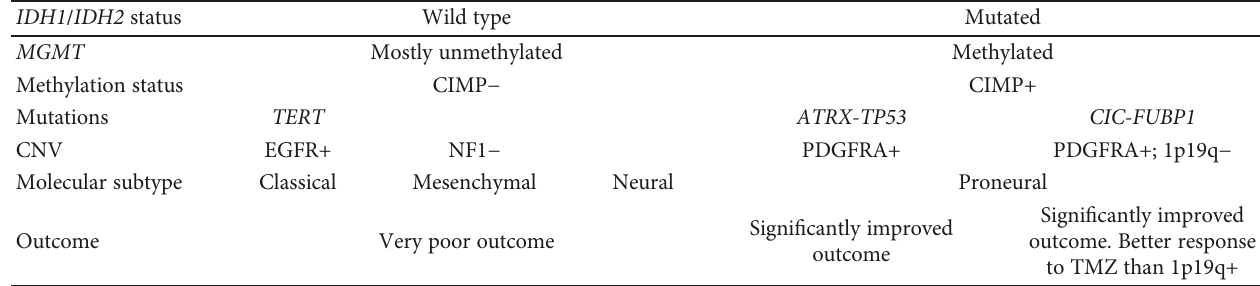
Table 1: Molecular characteristics of glioblastoma subtypes according to methylation, expression, mutation, copy number variations patterns, and clinical